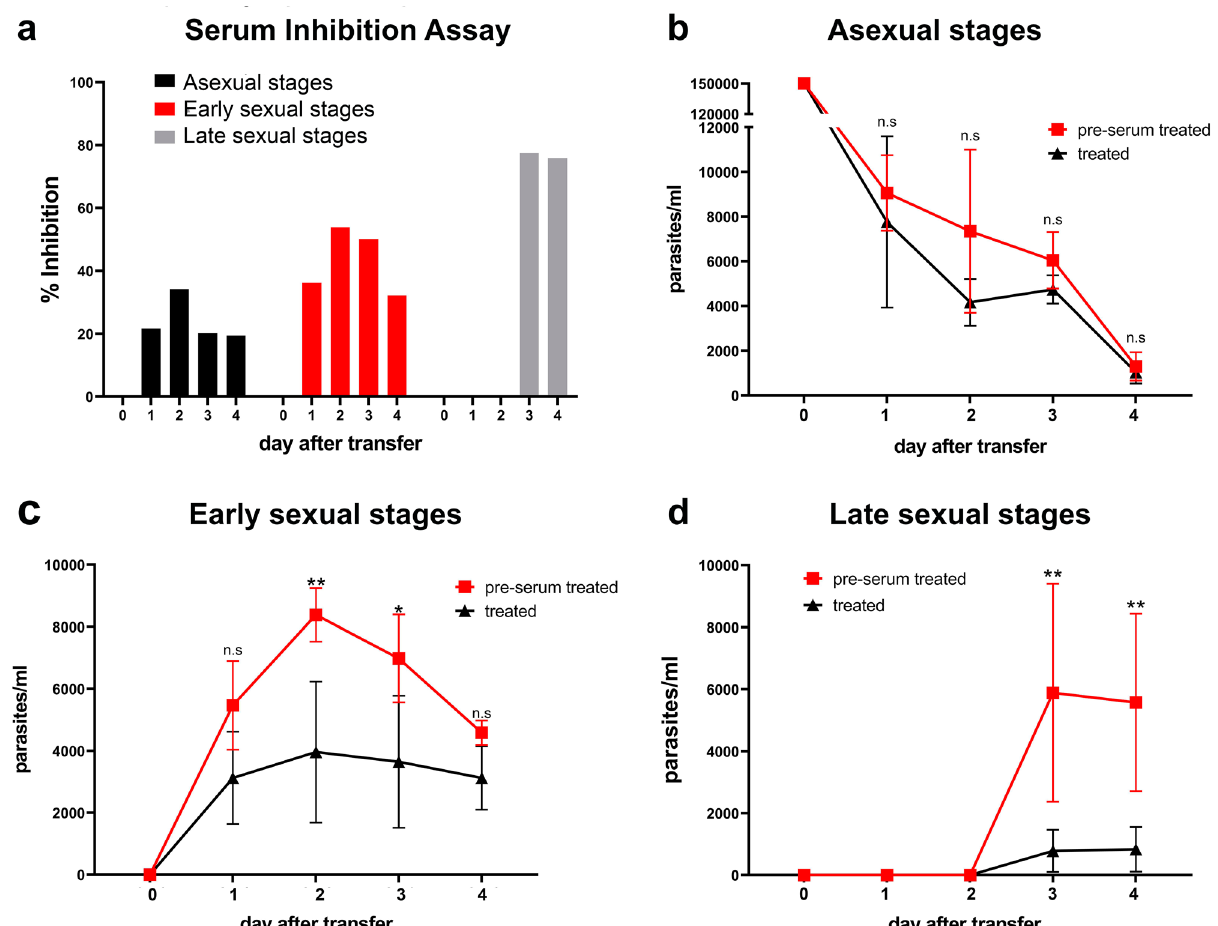
Figure 6. Serum Inhibition assay. ( a ) Inhibition rates for asexual, early (mostly gamonts) and late (mostly gametes) sexual stages of C. suis in a host-cell free culture 0–4 days after transfer of merozoites. ( b to d ) Total numbers of counted stages by day of cultivation in host-cell free culture. n.s.: not singificant, *: P ≤ 0.05, **: P ≤ 0.01. Values represent the mean ± standard deviation (SD) from three independent experiments. n.s.: not singificant, *: P ≤ 0.05, **: P ≤